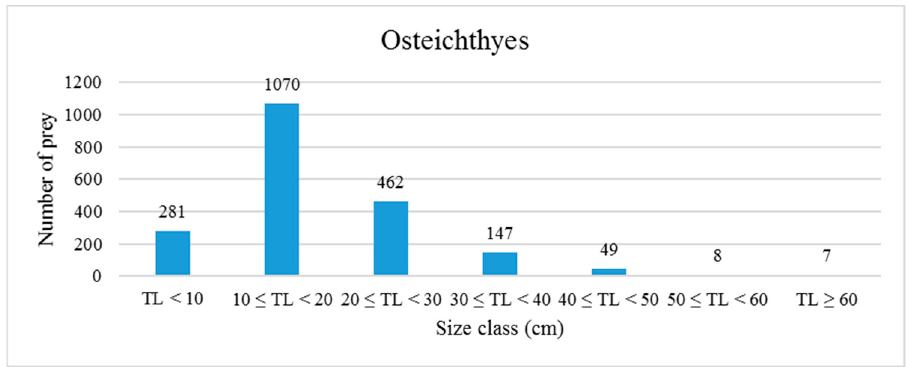
Figure 5. Frequency distribution of prey (fishes) according to size classes. TL: Total length.